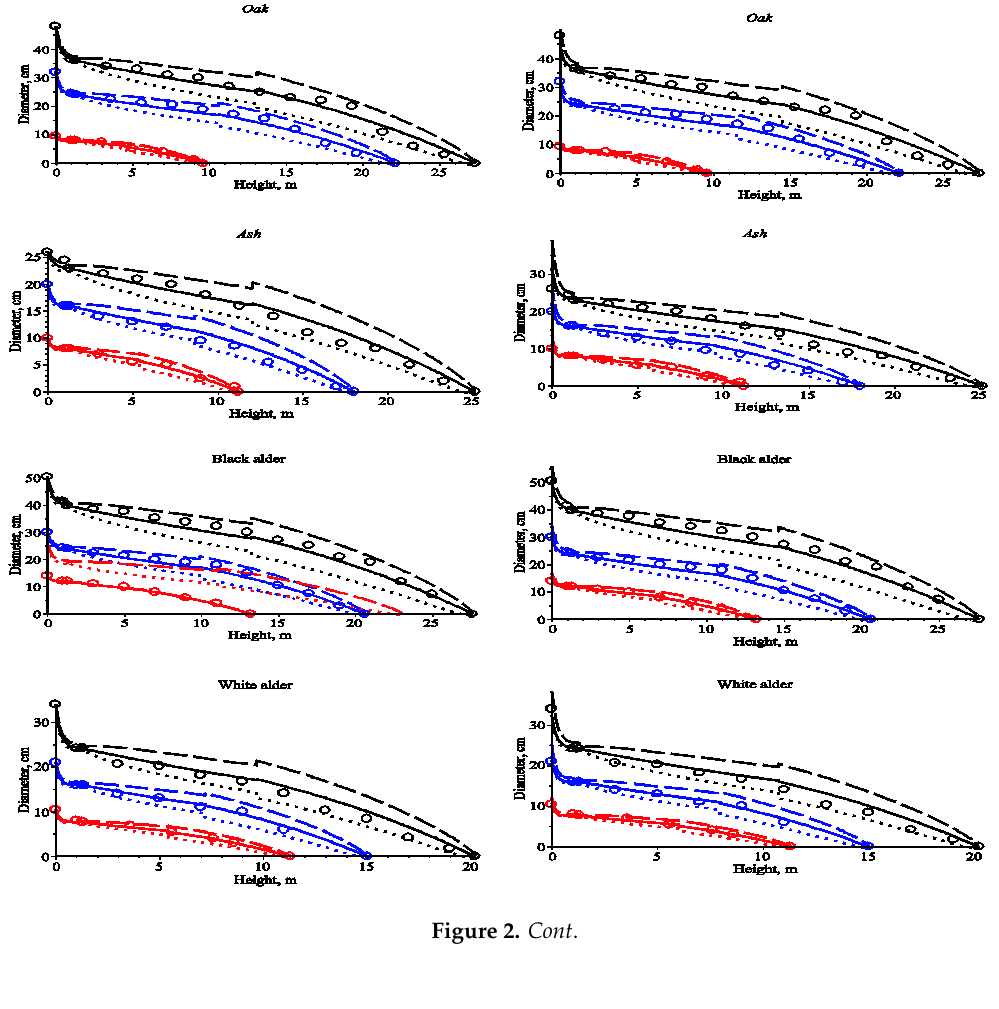
Figure 2. Evolution of the mean and p -quantile for stem diameter. Left shows Model 1, right shows Model 3. The large tree is denoted in black, the medium tree in blue, and the small tree in red. The mean trajectory is denoted with the solid line, the 0.025-quantile trajectory is denoted with the dotted line, and the 0.975-quantile trajectory is denoted with the dashed line.